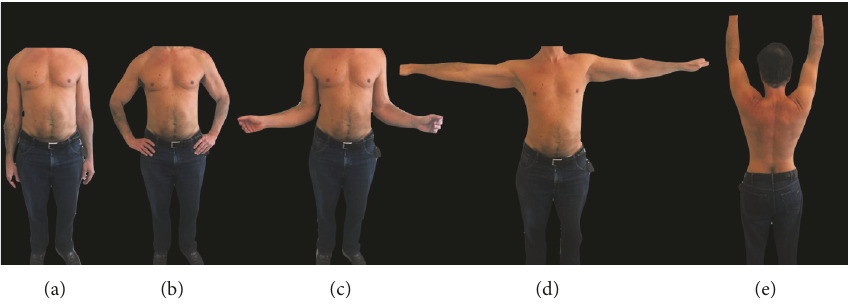
Figure 1: Clinical examination revealed no gross deformities or muscle atrophy on the left shoulder comparative to the contralateral upper limb. The range of motion of the left shoulder was preserved with functional shoulder symmetry. (a) Neutral position. (b) Internal rotation.